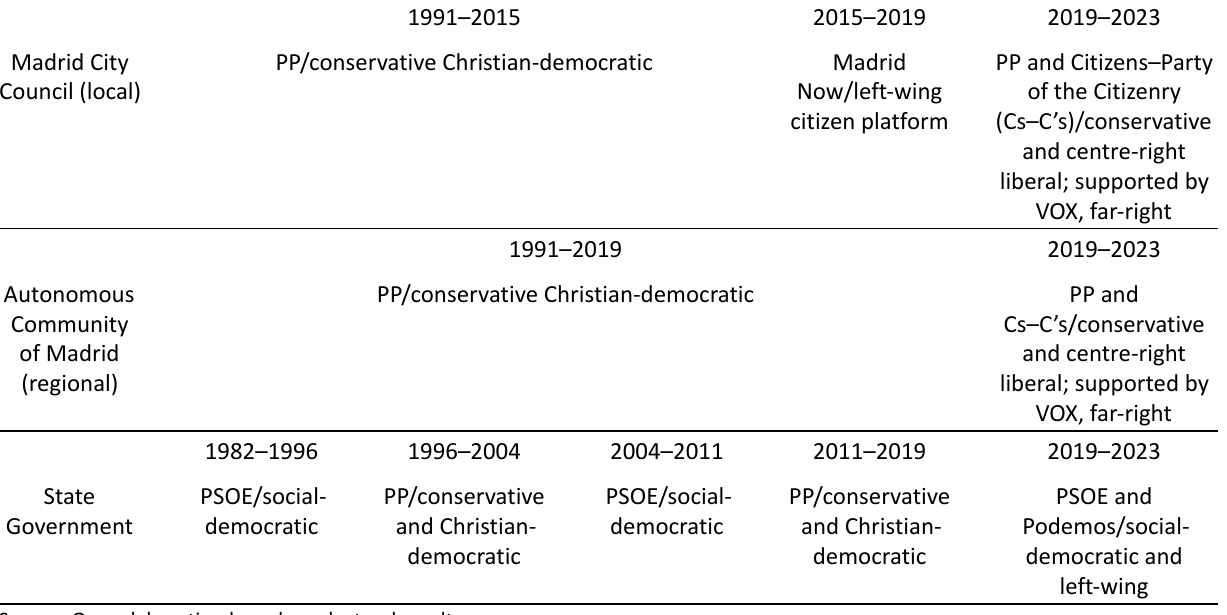
Source: Own elaboration based on electoral